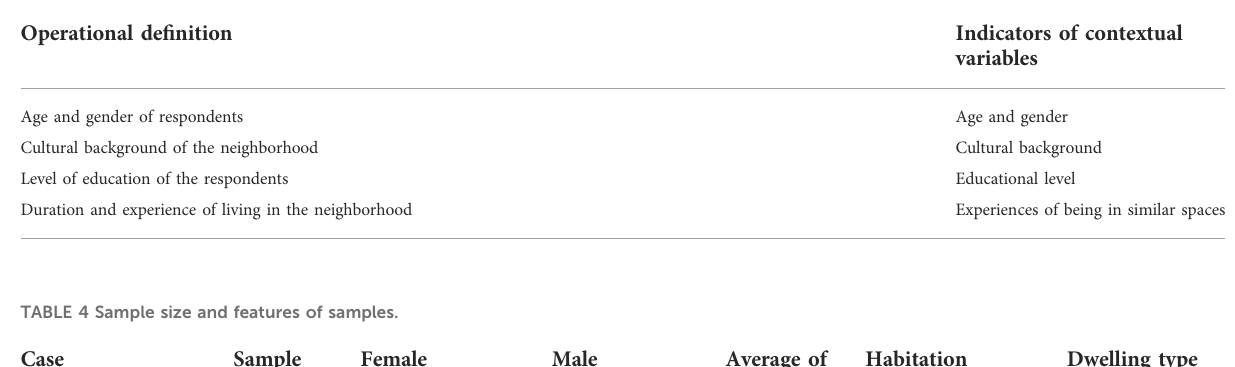
TABLE 3 Operational de fi nition of indicators related to the context variable (Source: Authors).